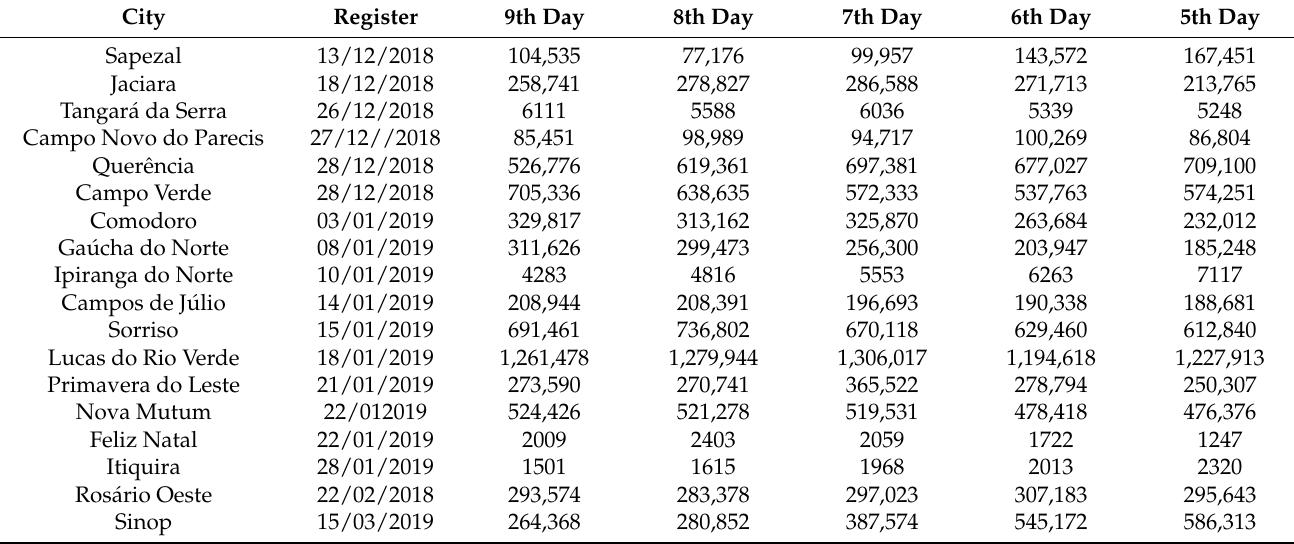
Table 3. The concentration of spores in locations where occurrences were recorded.